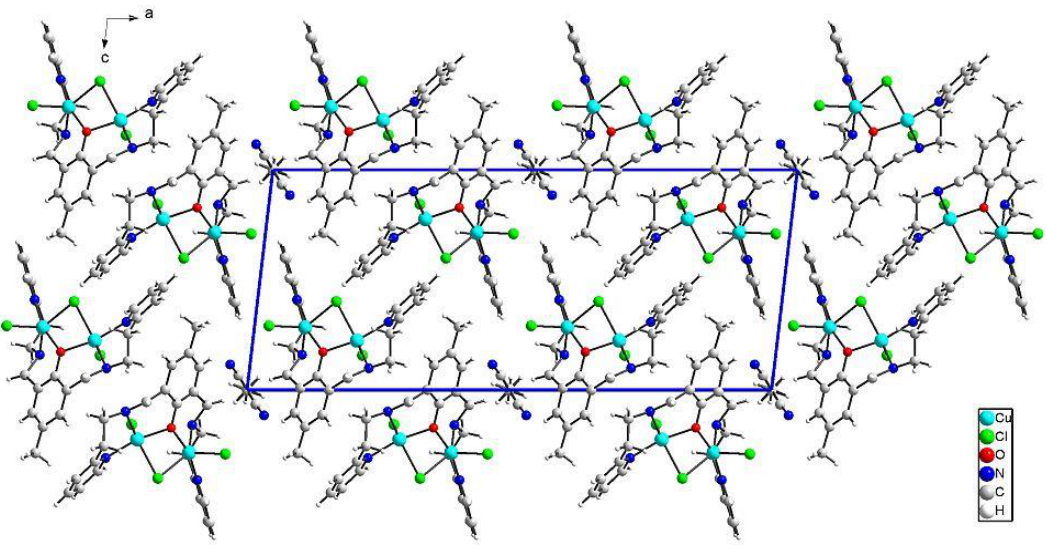
Figure 5. Packing of 2 along b axis reveals motif of π - π interactions between aromatic rings: stacking between two N10 units and rather edge-to-face in case of N30-N30 and N10-N30 interactions.